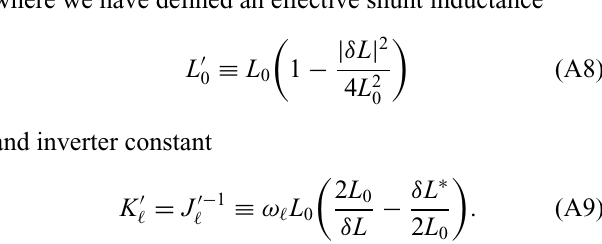
FIG. 23. Equivalent two-port circuit networks for an arbitrary (a) Z matrix and (b) Y matrix. The center element is represented by the equivalent inverterlike transmission